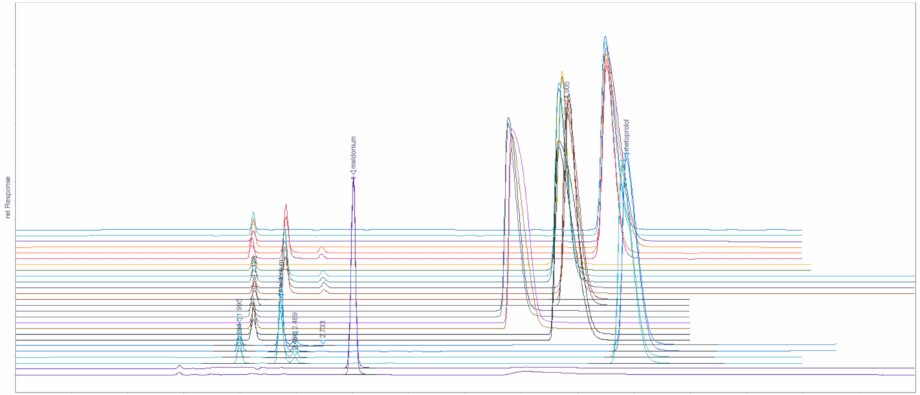
Figure 50. Chromatograms, obtained for use in CN-cyano column, Zorbax CN-SB 250 × 4.6 mm for simultaneous determination of meldonium with metoprolol. Numerous combinations of ACN with 0.15% NH 4 H 2 PO 4 have been presented overlaid at 195 nm and 200 nm, compared with the last two chromatograms on the bottom, which are made of on 100 × 4 mm C18 Xterra column with 10% ACN and not eluting metoprolol even to 20